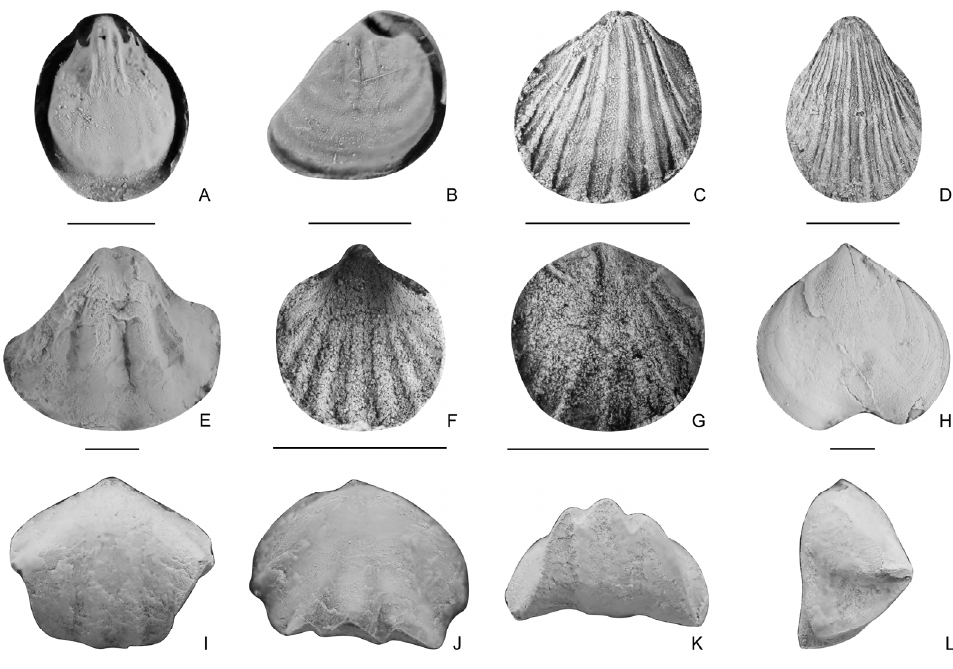
Figure 5. ( A , B ), Spirigerellina sp., ( A ), an internal mould of a ventral valve, LD215553; ( B ), an internal mould of a dorsal valve, LD215554. ( C , D ), Hustedtiella planicosta , ( C ), an internal mould of a dorsal valve, LD380056; ( D ), an internal mould of a ventral valve, LD380272. ( E ), Schwagerispira ? sp., a ventral valve, LD435623. ( F , G ), Neoretzia sp., ( F ), an external mould of a ventral valve, LD380267; ( G ), an internal mould of a dorsal valve, LD380172. ( H ), Norella sp., a ventral valve, LD435517. ( I – L ), Nudirostralina trinodosi , ventral, dorsal, anterior and lateral views of a conjoined shell, LD381185. Scale bar = 2 mm.